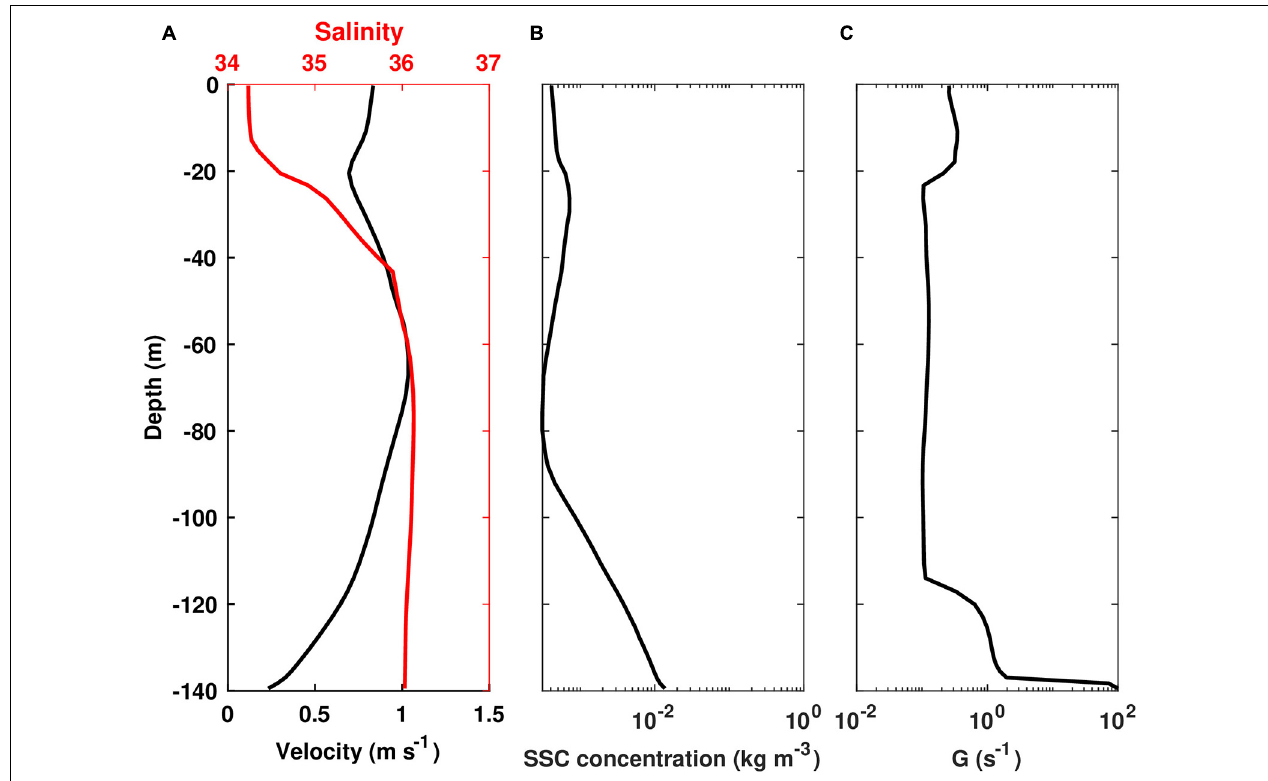
FIGURE 6 | Profiles of (A) velocity and salinity, (B) initial suspended sediment mass concentration, and (C) shear rate for the hurricane scenario ( A,B are based on model output from Harris et al., 2020. C is from 1D model output).